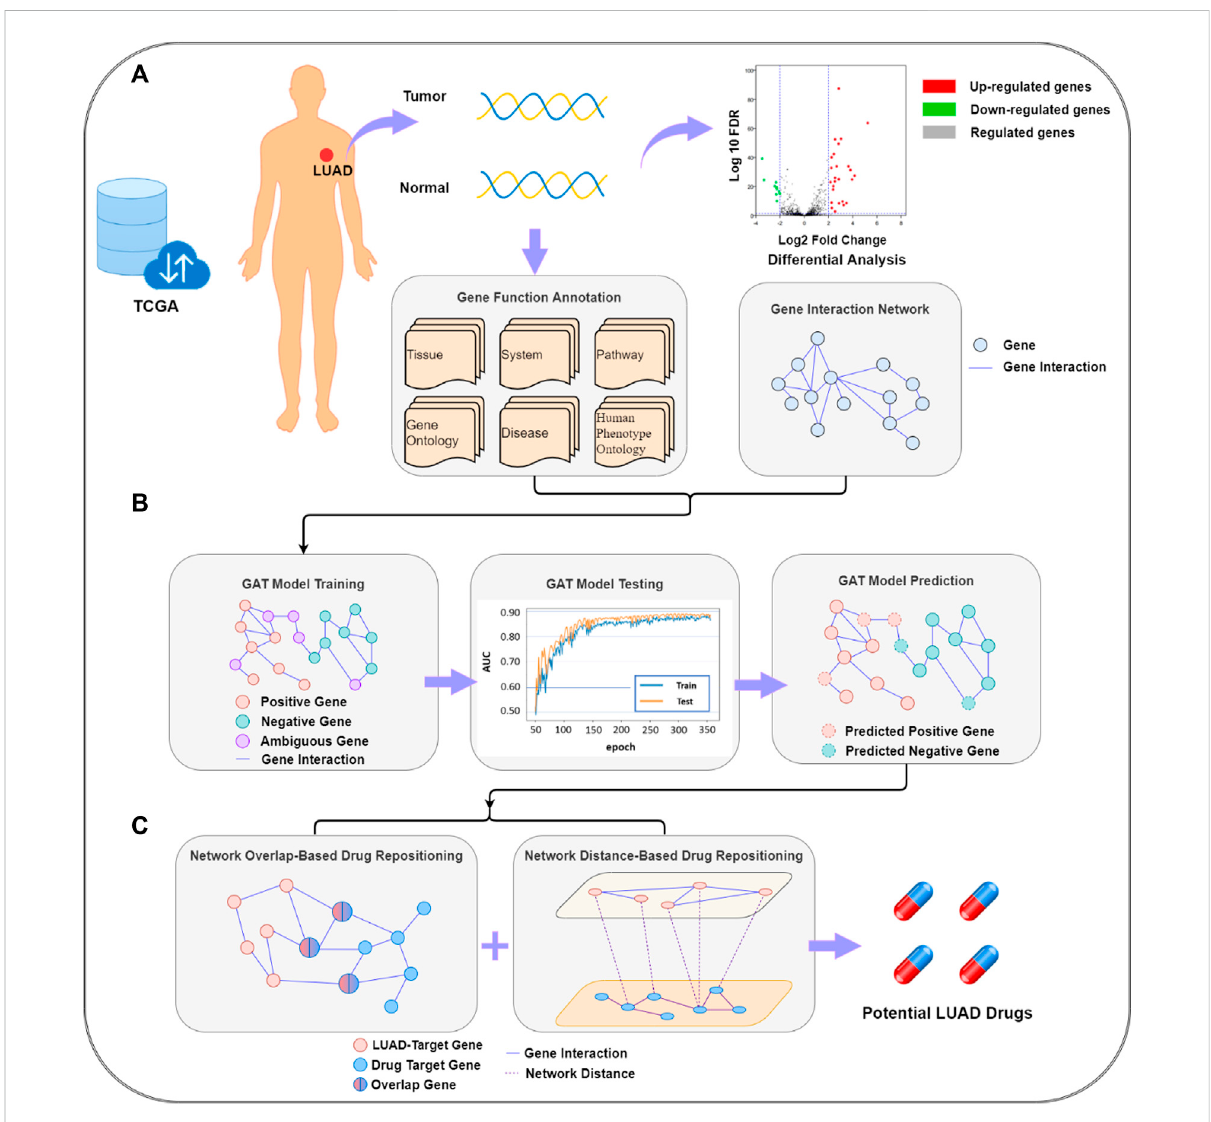
FIGURE 1 Lungadenocarcinoma target gene prediction – drug repositioning pipeline. (A) data collection and pre-processing; (B) graph attention network (GAT)modelbuildingandlungadenocarcinoma(LUAD)-relatedtargetgeneprediction; (C) potentialLUADdrugprediction.FDR,falsediscoveryrate; TCGA, The Cancer Gene